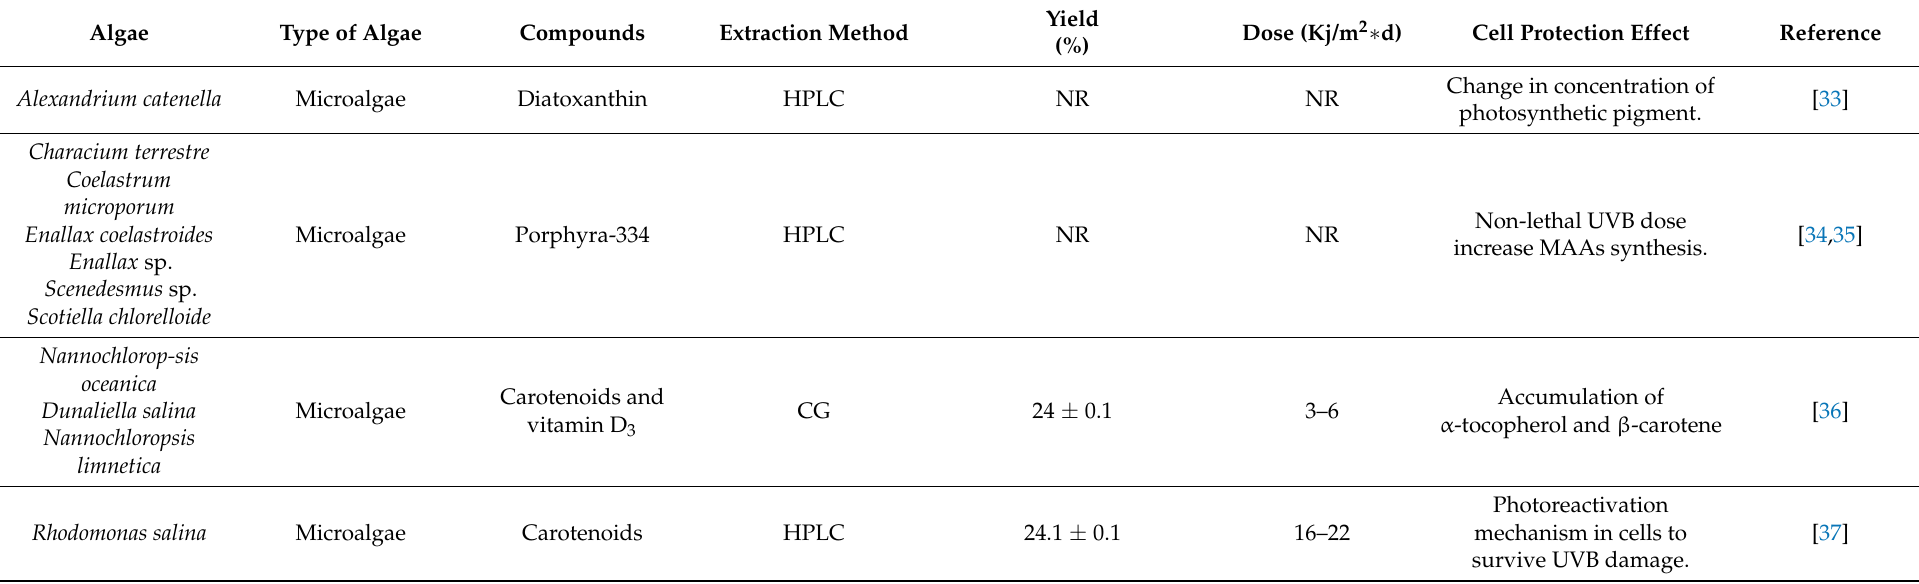
Table 2. Algae compounds obtained by UVB irradiation.